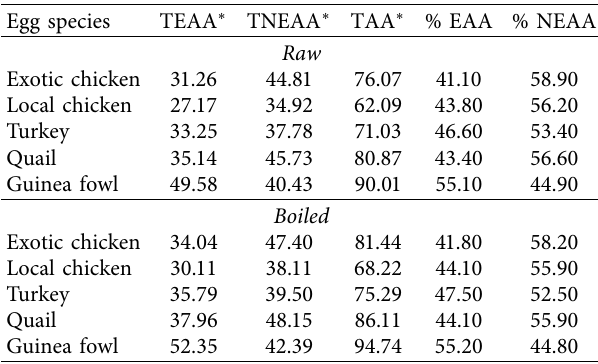
Table 3: Summary of amino acid